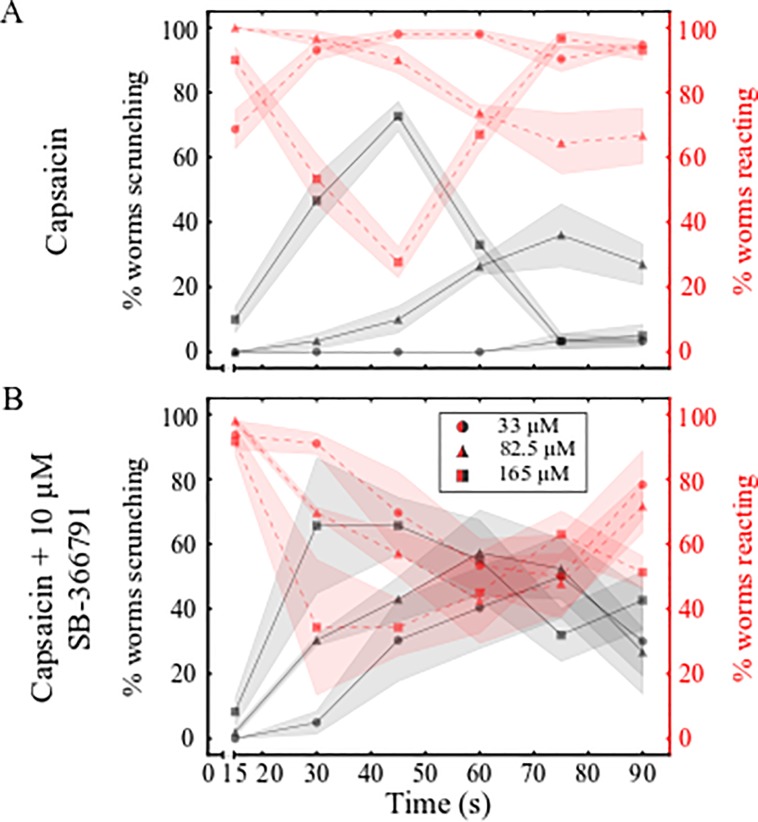
Scrunching in capsaicin is enhanced by SB-366791.(A-B) Behavior scoring plots for D. japonica showing the percentage of worms scrunching (black lines) or reacting (non-scrunching behaviors, red lines) every 15 s over 90 s when exposed to (A) capsaicin or (B) capsaicin + 10 μM SB-366791. Markers and shading represent the mean and standard deviation of 3 technical replicates, respectively.